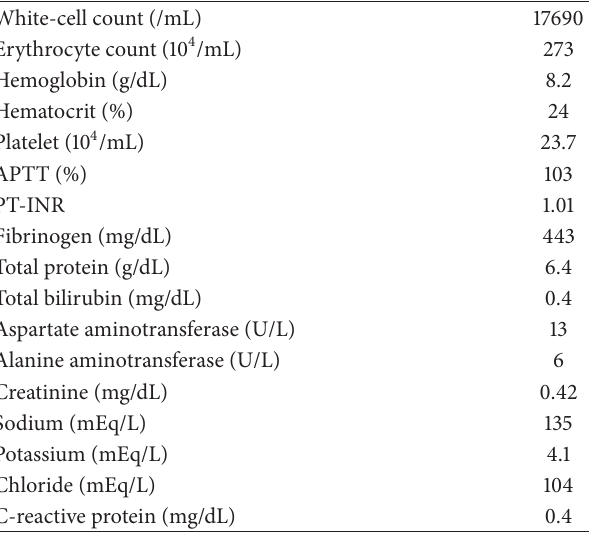
Table 1: Laboratory data on